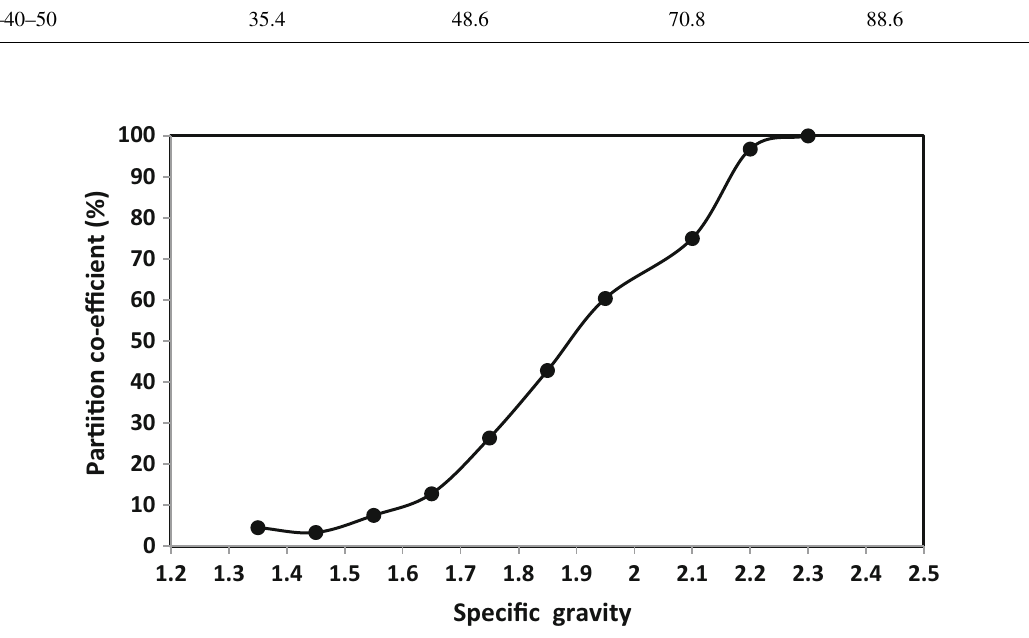
Fig. 11 Partition curve of the separation